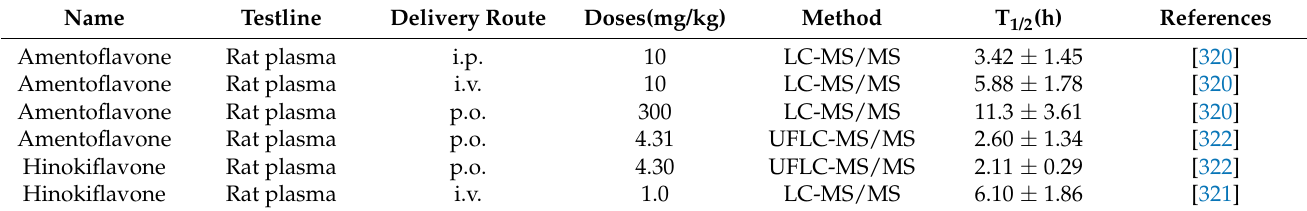
Table 12. The pharmacokinetics of